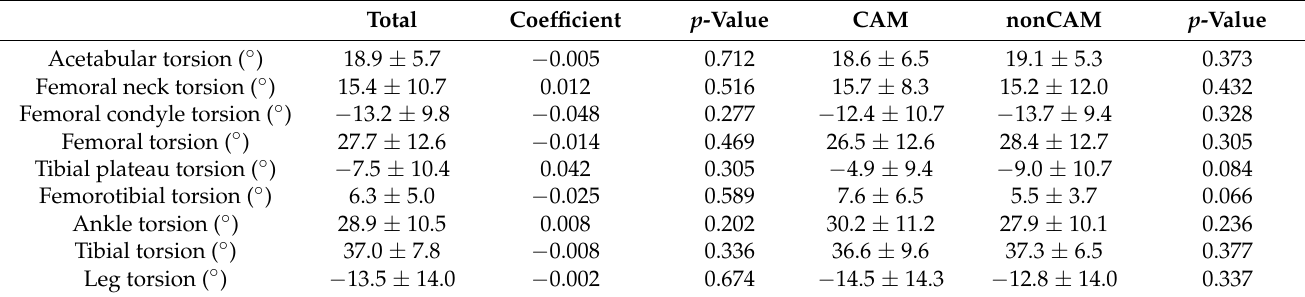
Table 4. Rotational computed tomography findings. Total